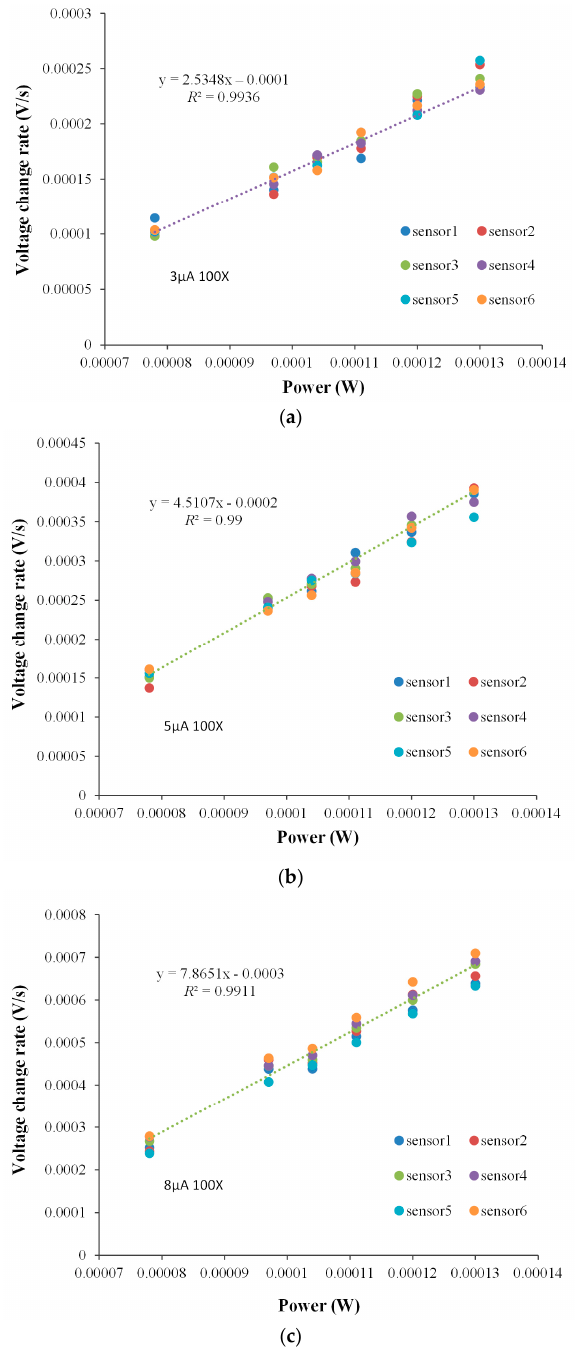
Figure 6. Heat pulse sensitivity for the proposed multichannel calorimetric simultaneous assay platform when various loop currents and six miniature chip heaters. Test results with respect to three loop currents: ( a ) 3 µA; ( b ) 5 µA; ( c ) 8 µA (Joule heating pulse time: 30 s).